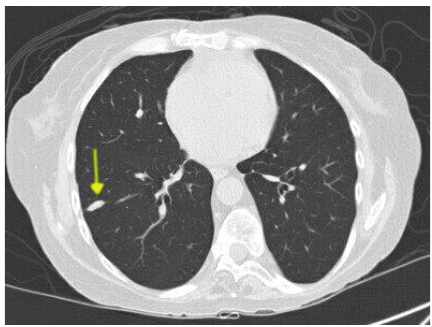
Figure 1: Computed tomography scan of the chest revealing a 19 × 8 mm nodule (arrow) involving the area of transbronchial biopsy on day 20 of the procedure.